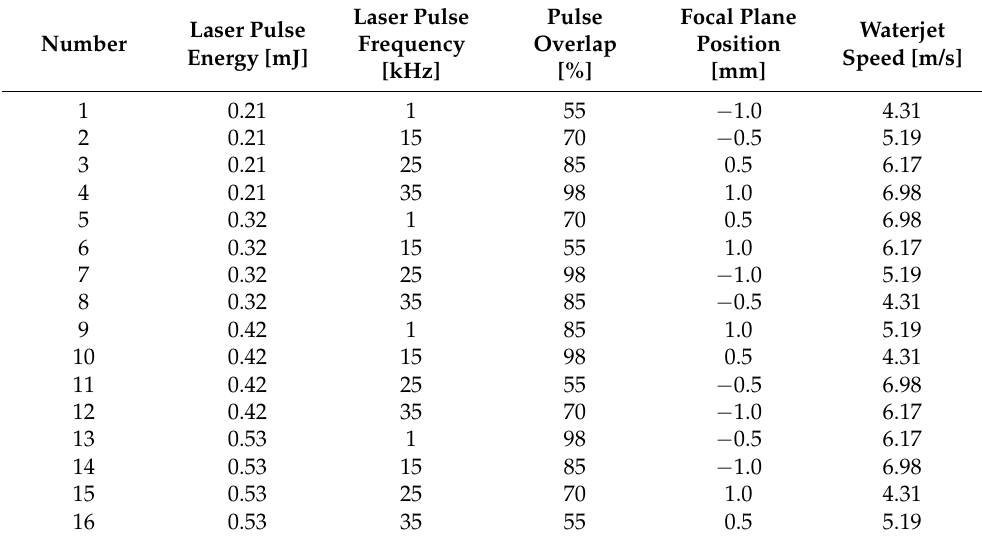
Table 5. Orthogonal experimental design.